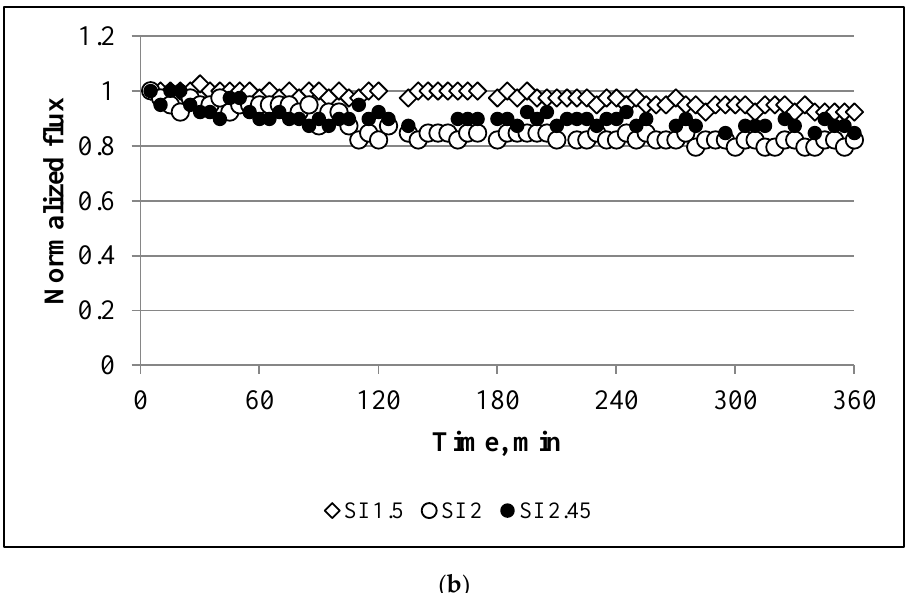
Figure 5. Normalized flux for: ( a ) NaCl + CaCl 2 + Na 2 SO 4 ; and ( b ) CaSO 4 × 2H 2 O at different saturation indices (Table 1 lists the concentrations of the salts). Experimental conditions: 12.5 cm/s cross-flow velocity; the feed and draw solutions were circulated counter-currently; and an AL-FS orientation. Figures 6a and 7a depict the influence that the cross-flow velocity has on membrane performance. A reduction in the cross-flow velocity from 12.5 to 3 cm / s intensifies the decline in the water flux, i.e., at 12.5, 6, and 3 cm / s the water flux at the end of experiment was equal to 64%, 55%, and 48%, respectively. Figures 7b and 8b show the e ff ect of the feed and draw solution pumping direction. The membrane yielded a slightly higher average water flux in counter-current flow mode.